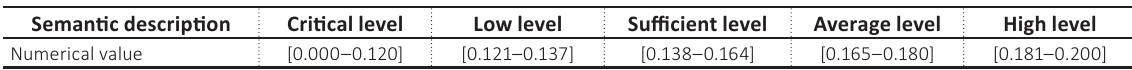
Source: Own elaboration.